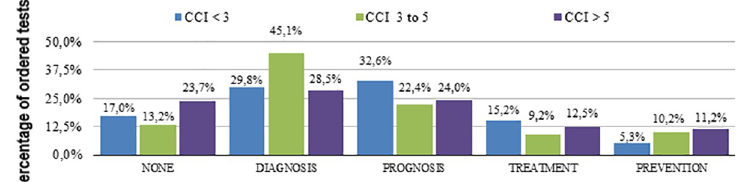
Fig 4. Tests usefulness according to bands of the Charlson Comorbidity Index